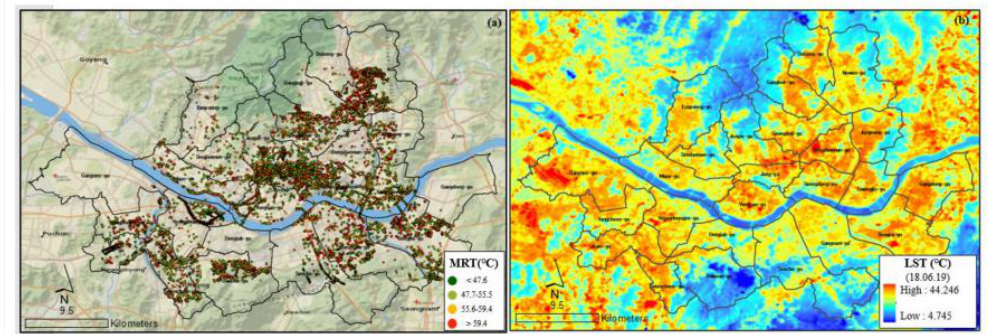
Figure A4. ( a ) Estimated MRT mapping using Google Street View in Seoul. ( b ) Land Surface Temperature map using Landsat 8 data in